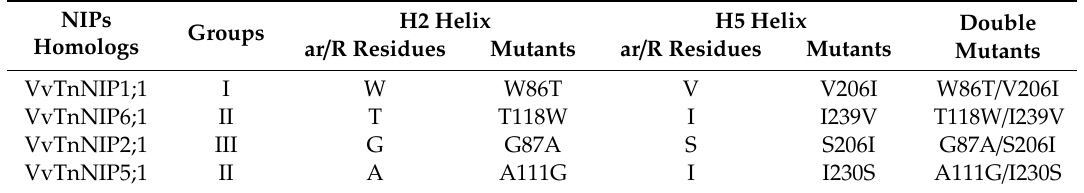
Table 2. List of residues in ar / R selectivity filter and their mutants of grapevine